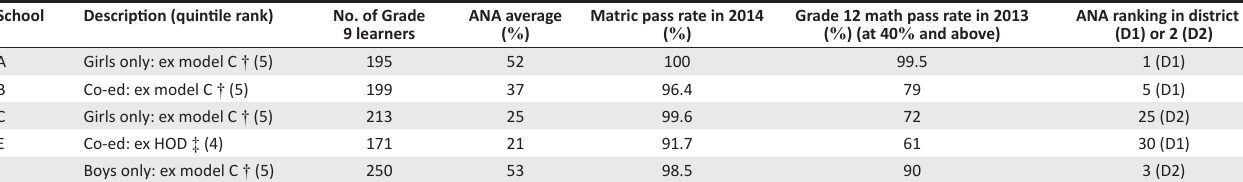
TABLE 1: Details of schools.